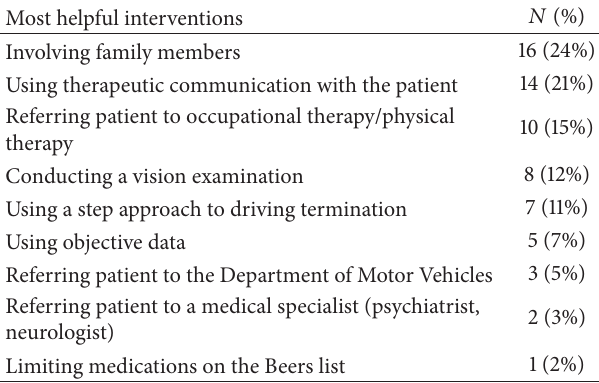
Table 3: Mosthelpfulinterventions formanaging older driversafety ( 𝑛 = 66